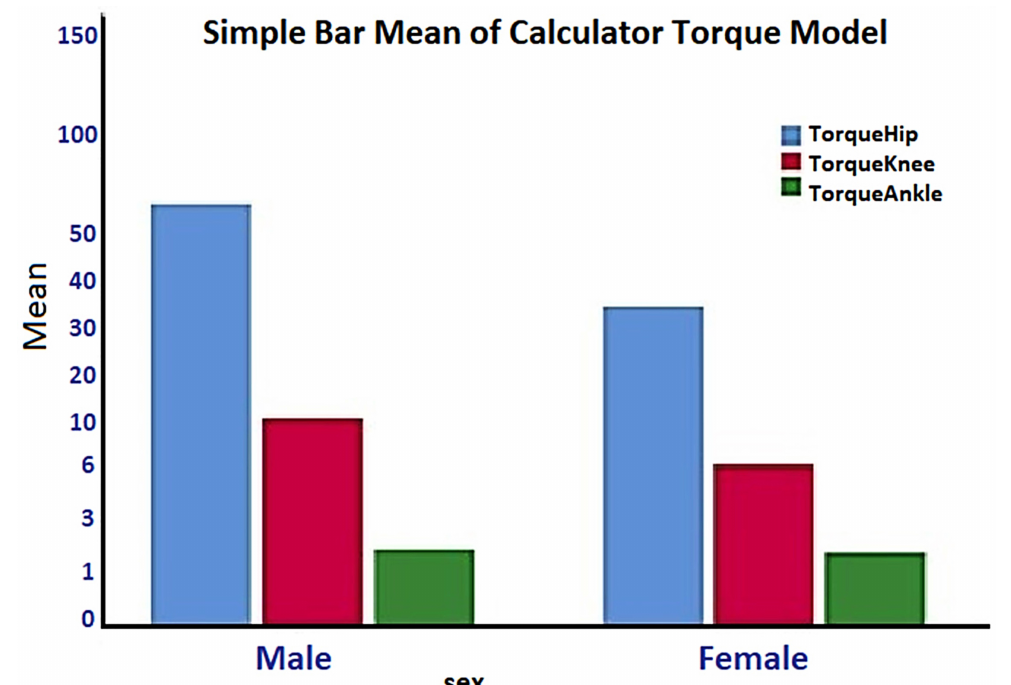
Figure 14. Simple Bar Mean of Calculated Torque—Male,